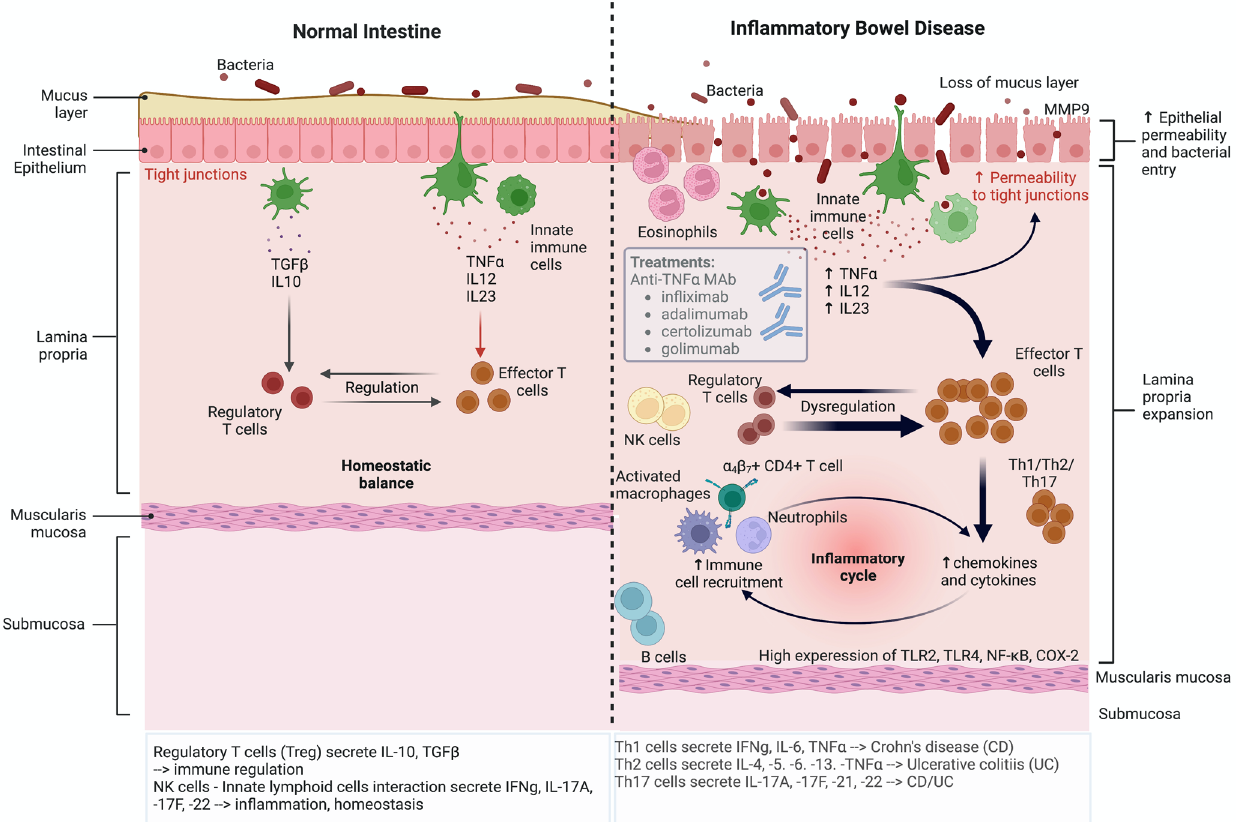
Figure 1. The immunological complexity of inflammatory bowel disease. CD, Crohn’s disease; COX-2, cyclooxygenase 2; IL, interleukin; IFN- γ , interferon gamma; MAb, monoclonal antibody; MMP9, matrix metallopeptidase 9; NF- κ B, nuclear factor kappa-light-chain-enhancer of activated B cells; NK, natural killer; Th, helper T cells; TLR, Toll-like receptor; TNF- α , tumour necrosis factor alpha; UC, ulcerative colitis. Created using